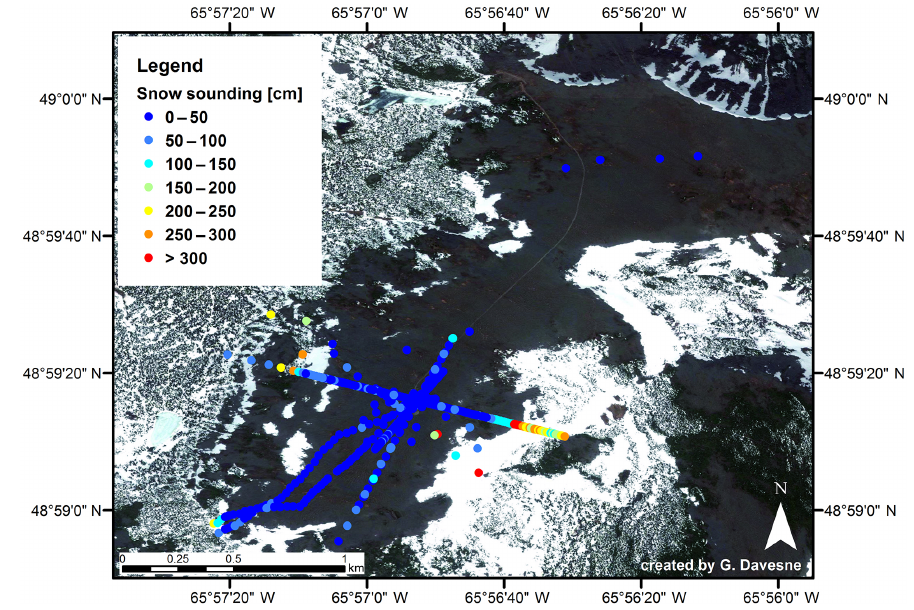
Figure 2. Compilation of snow measurements made in 1979, 1980, 2009, 2010, 2011, 2012, and 2013 over the Mont Jacques-Cartier summit. The Spot-5 image in the background was taken on 28 May 2013 (Google Earth, 2013) and thus shows only residual snow patches.